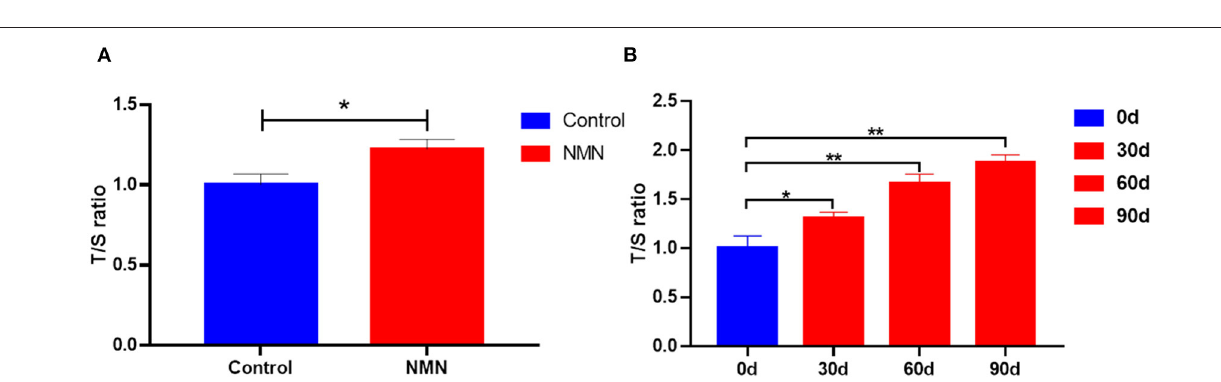
FIGURE 7 | Correlation analysis for differentially changed bacteria and metabolites with NMN supplementation in pre-aging mice.